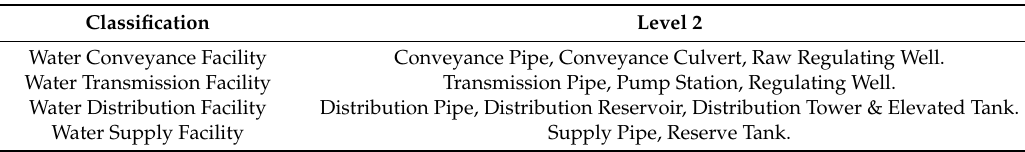
Table 4. Inventory composition of Level 2.